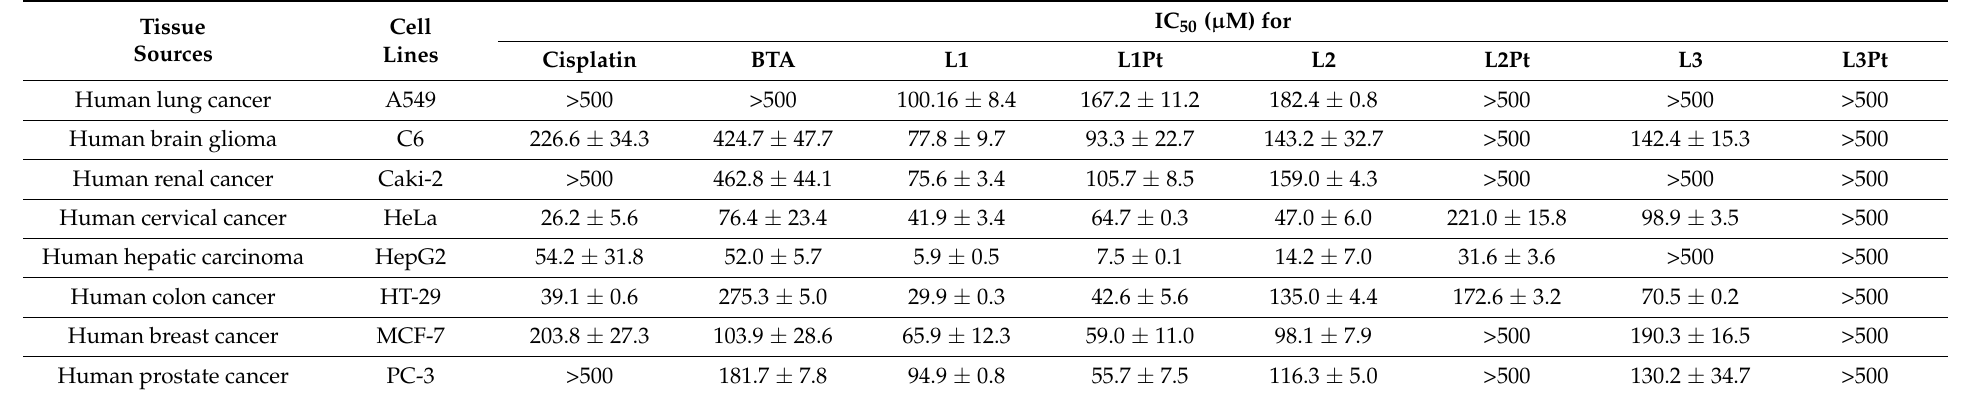
Table 1. Half inhibition concentrations (IC 50 ) of synthesized compounds in cancer cells. Various cancer cells treated with different concentrations of compounds were assayed for cell viability by the CCK-8 method at 24 h and IC 50 values were calculated using the GraphPad Prism 5 software. IC 50 values for compound against each cell line are means of three independent experiments [( n = 3, mean ± SEM (standard error of mean)]. Cisplatin and BTA, which are the backbones of the compounds, were compared as positive controls.